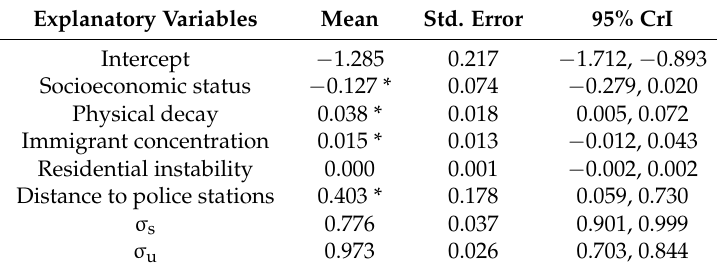
Table 2. Beta Regression Model with Dependent Variable: drug-related police interventions.